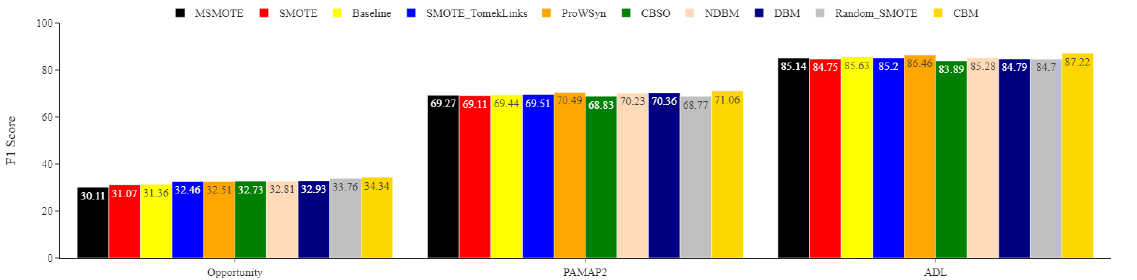
Figure A3. F 1 score of baseline (LR), the proposed method, and the sampling methods for the Opportunity, PAMAP2 and ADL datasets. The reported means of F 1 scores were obtained from 30 repetitions.